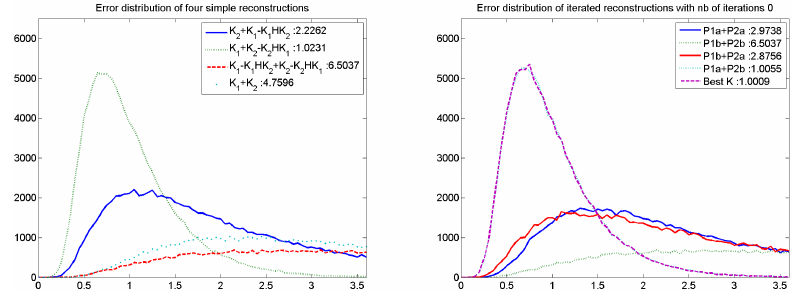
Figure C2. Histogram of scaled errors for simple reconstructions of the total field (left) and with 0 iterations in the new formulations (right). For reference, the distribution of the optimal solution is also shown, proving that not only is the average error of the new method combining P1a and P2b optimal, but also that the error distribution falls along the optimal